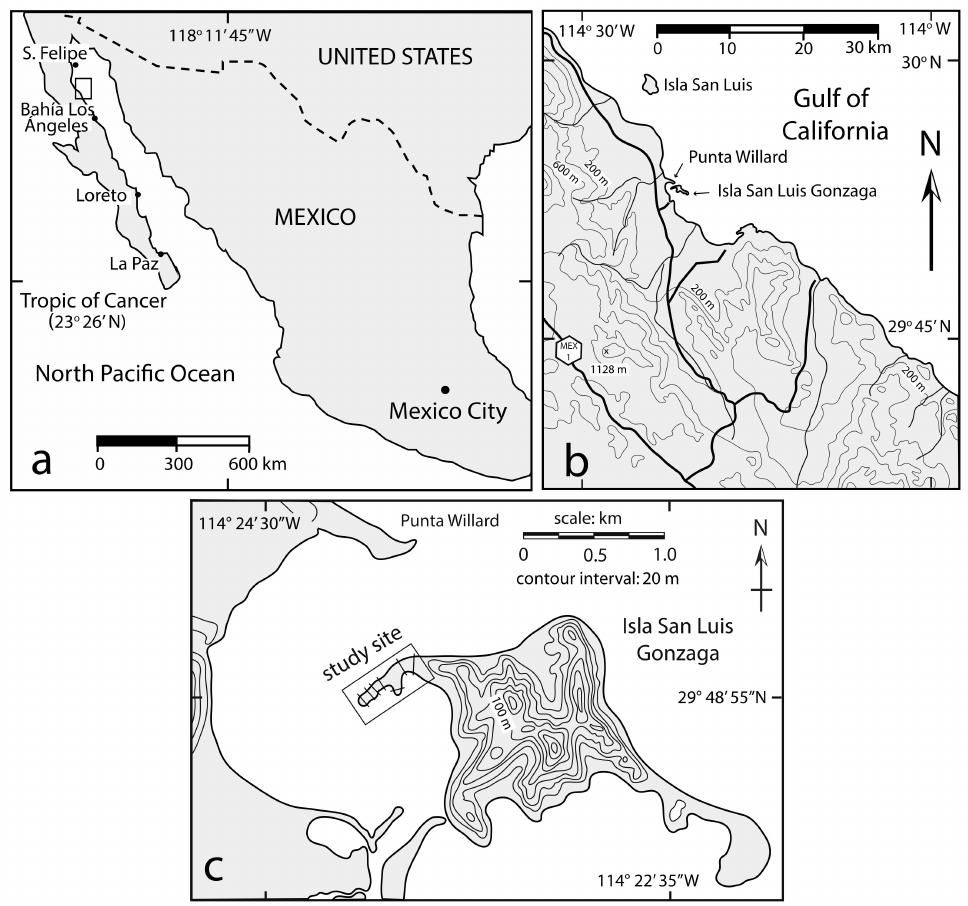
Figure 1. Locality maps showing Mexico’s Baja California peninsula and Gulf of California; ( a ) Mexico and border area with the United States denoting key towns with inset box marking the study area between San Felipe and Bah í a de Los Angeles; ( b ) Region around Bah í a San Luis Gonzaga showing Isla San Luis Gonzaga in the northwest part of the bay; ( c ) Topographic map of Isla San Luis Gonzaga with the study site marked (box) within which the study transects are